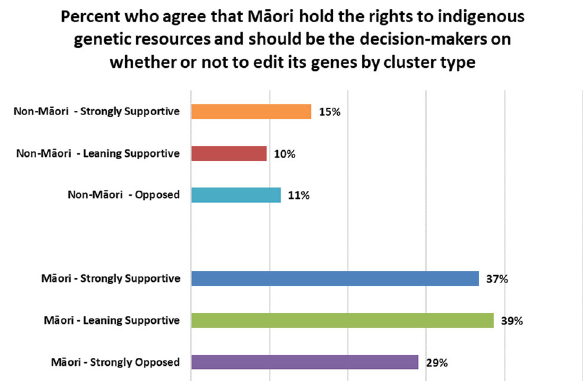
Fig. 10 Support for M ā ori to have the rights to and fi nal determination of editing taonga species, by clusters. All M ā ori clusters are more supportive of M ā ori holding the rights to taonga species than the non-M ā ori clusters. However, across all six clusters, it is only a minority of members who support the stance (ranging from 10% to 39%). Non-M ā ori Strongly Supportive are shown in orange, non-M ā ori Leaning Supportive red, non- M ā ori Opposed light blue, M ā ori Strongly Supportive dark blue, M ā ori Leaning Supportive green, and M ā ori Strongly Opposed